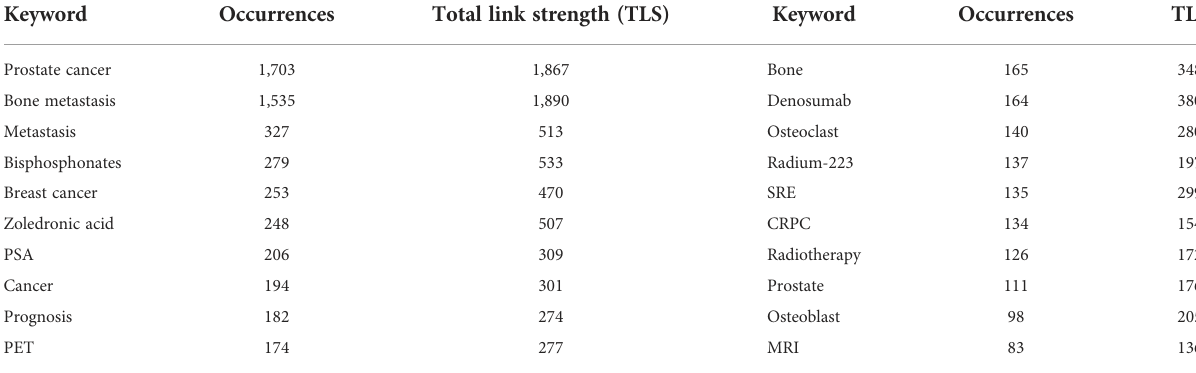
TABLE 6 Top 20 author keywords with the most occurrences in the included articles.